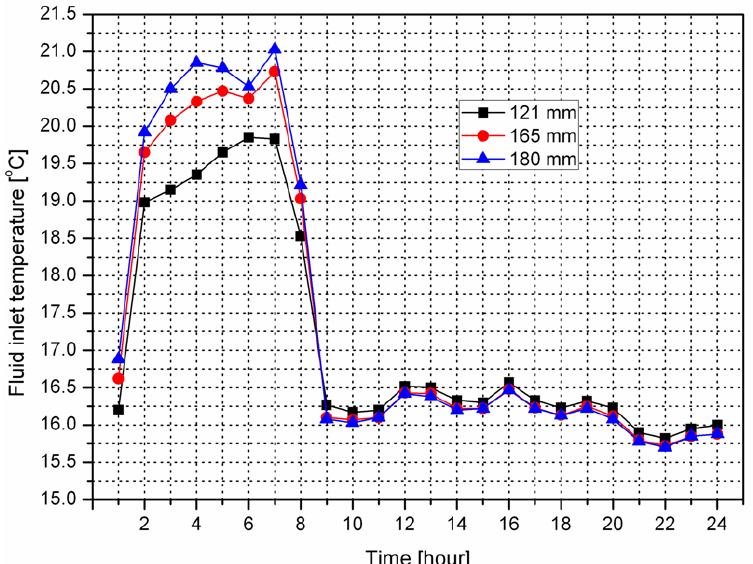
Figure 9. Hourly fluid inlet temperature distribution of the three investigated three blocks BHEs on August 07, 2009.